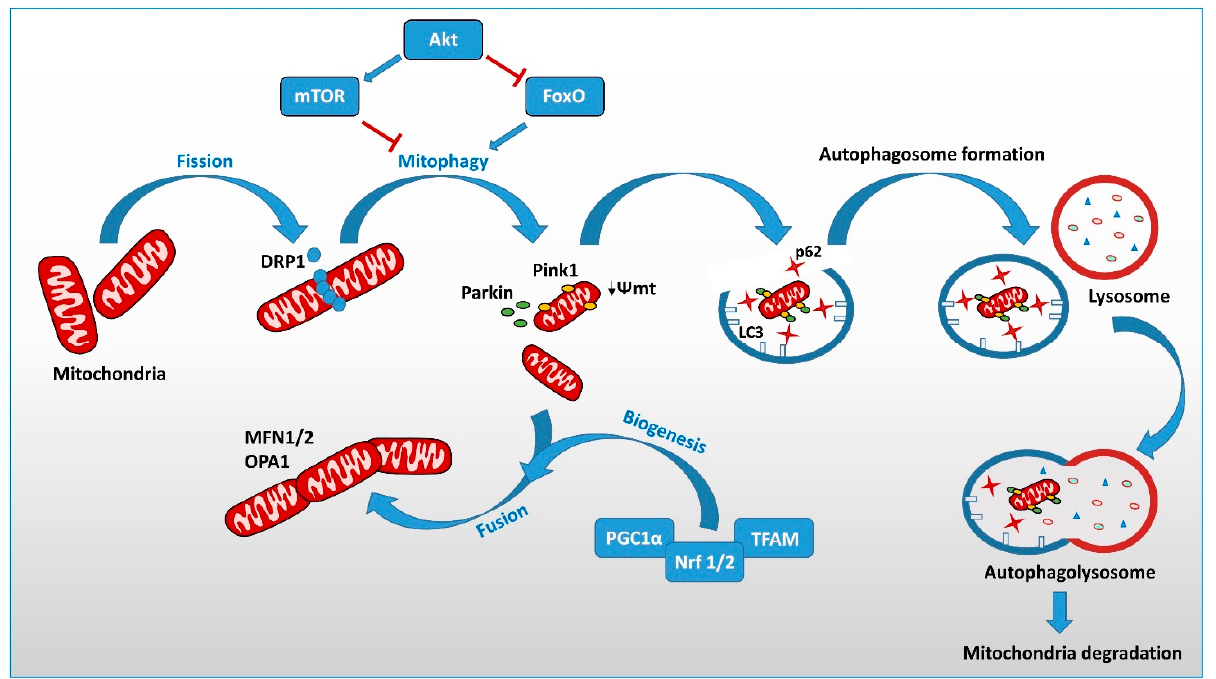
Figure 1. Schematic representation of mitochondrial dynamics and mitophagy process. Drp1 has a pleckstrin-homology (PH) domain that mediates binding at membrane phospholipids. Its recruitment to the OMM needs the scission of multiple membrane- anchored adaptors, including Fis1, tail-anchored proteins, mitochondrial fission factor (MFF), and mitochondrial dynamics proteins 49 and 51 (MiD49 and MiD51) [152].